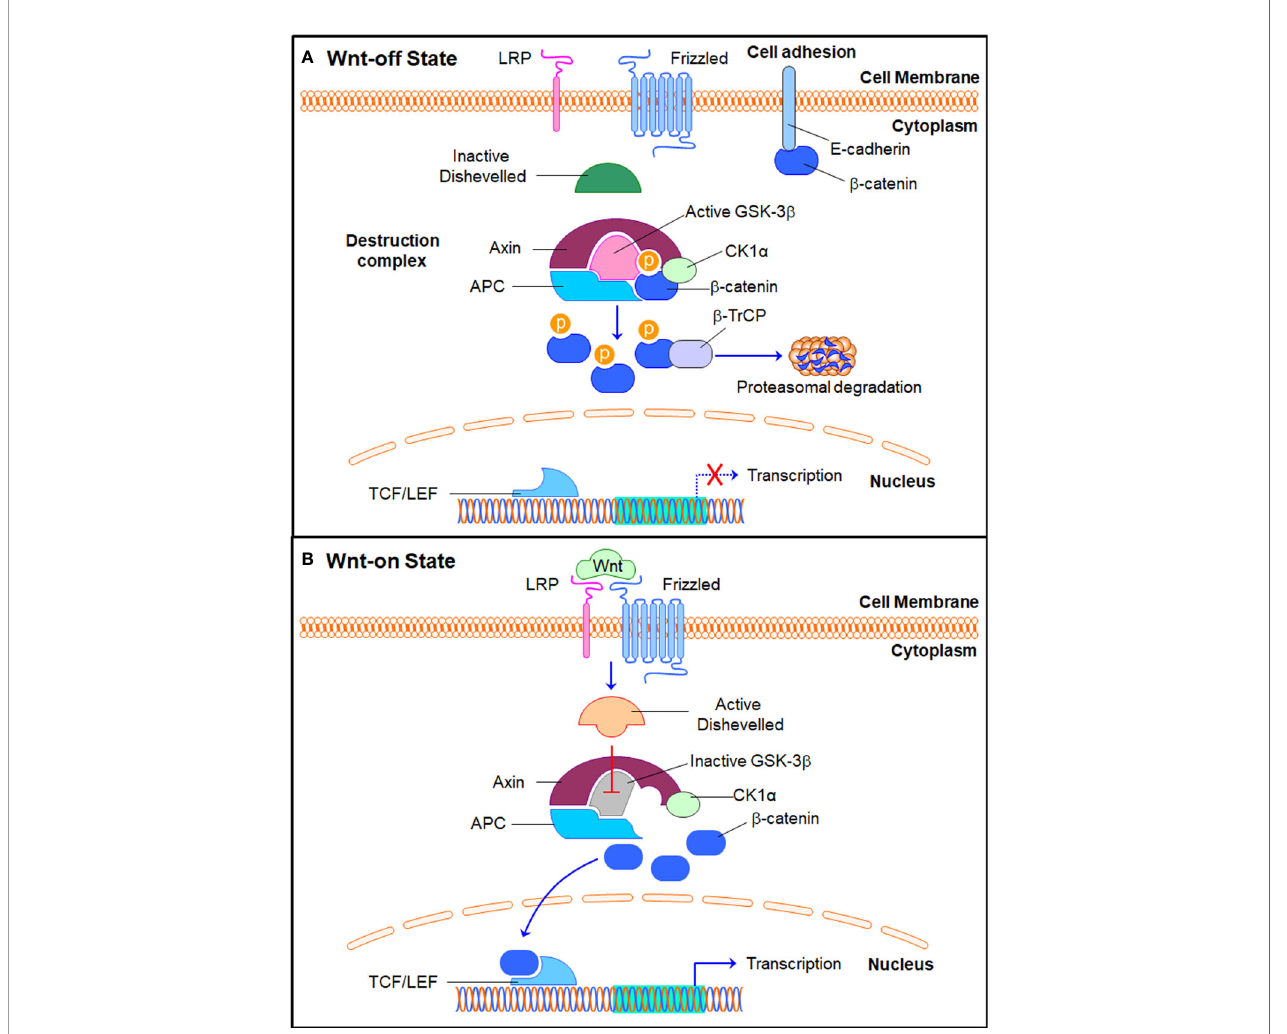
FIGURE 1 | The Wnt/ b -catenin signaling pathway. (A) In the Wnt-off state, the b -catenin destruction complex is formed by Axin, APC, GSK3 b , and CK1 a and promotes the phosphorylation of b -catenin. The E3 ligase b -TrCP further induces b -catenin ubiquitination and proteasomal degradation. E-cadherin and b -catenin also form complex to enhance cell adhesion. (B) In the Wnt-on state, Wnt proteins bind to Frizzled receptor and LRP co-receptor and recruit and activate Dishevelled, which further inhibits the activity of GSK3 b and releases b -catenin from the destruction complex. The stable b -catenin subsequently translocates into the nucleus, interacts with TCF/LEF, and promotes the transcription of its down-stream target genes. APC, adenomatous polyposis coli; b -TrCP, b -Transducin repeat- containing protein; CK1 a , casein kinase 1 a ; GSK3 b , glycogen synthase kinase 3 b ; LRP, low-density lipoprotein receptor-related protein; TCF/LEF, T cell factor/ lymphocyte enhancer